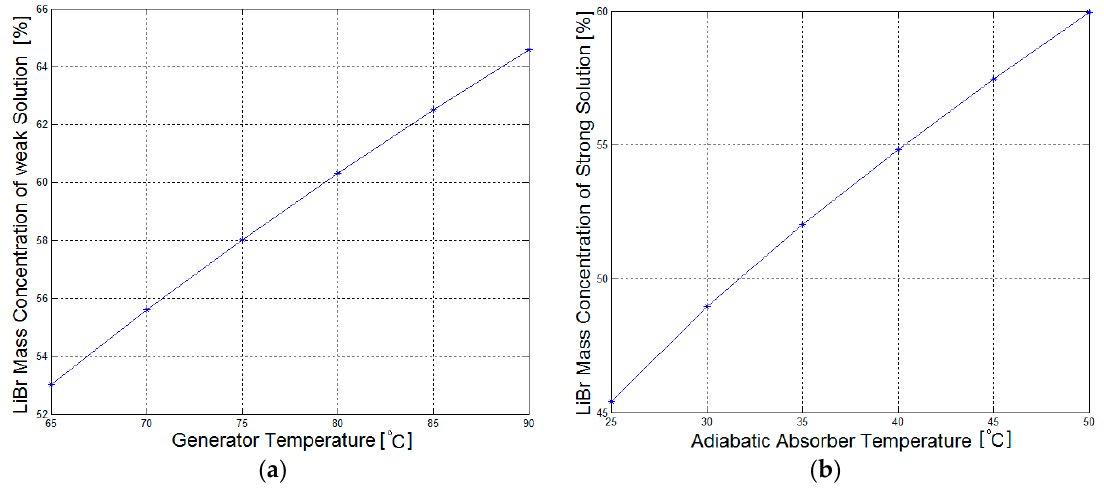
Figure 4. Graphs showing the variation of the LiBr mass concentration of: ( a ) the weak solution with generator temperature ( T con = 35 ◦ C, T eva = 10 ◦ C ) ; and ( b ) the strong solution with adiabatic absorber temperature ( T con = 35 ◦ C, T eva = 10 ◦ C )